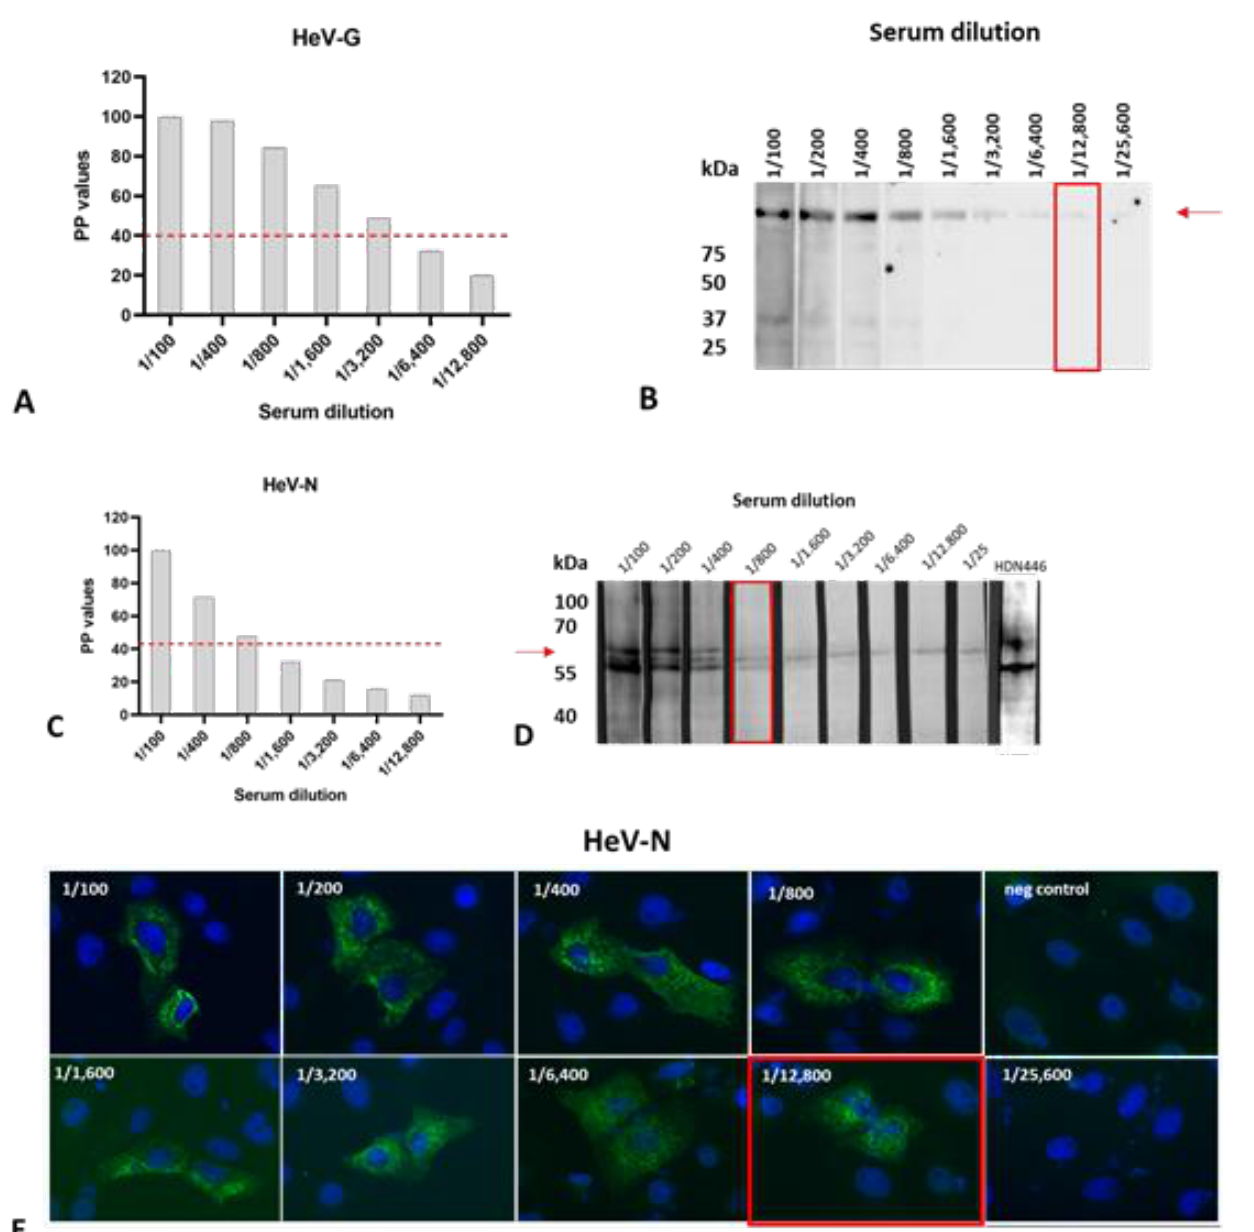
Figure 3. ASe of the ELISA, Western blot, and IF analysis as determined for serial dilutions of a known positive control serum. Detection limits for HeV-G were determined as ( A ) 1/3200 for the HeV-G ELISA using HeV-G expressed in L. tarentolae as antigen, and ( B ) as 1/12,800 for the HeV-G Western blot using a commercially available HeV-G expressed in HEK 293T cells as antigen. The detection limits for HeV-N were determined as ( C ) 1/800 for the HeV-N ELISA expressed Sf9 insect cells and ( D ) the HeV-N Western Blot using HeV-N expressed in HEK 293T cells as antigen, and ( E ) as 1/12,800 for IF analysis using HeV-N expressed in Vero76 cells as antigen. Red arrows indicate the expected molecular masses of HeV-G and HeV-N, respectively.